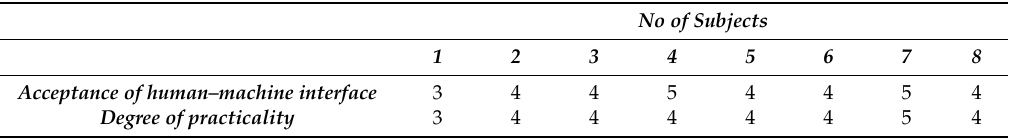
Table 4. The mean opinion scores (MOS) regarding the acceptance of user friendly and the degree of